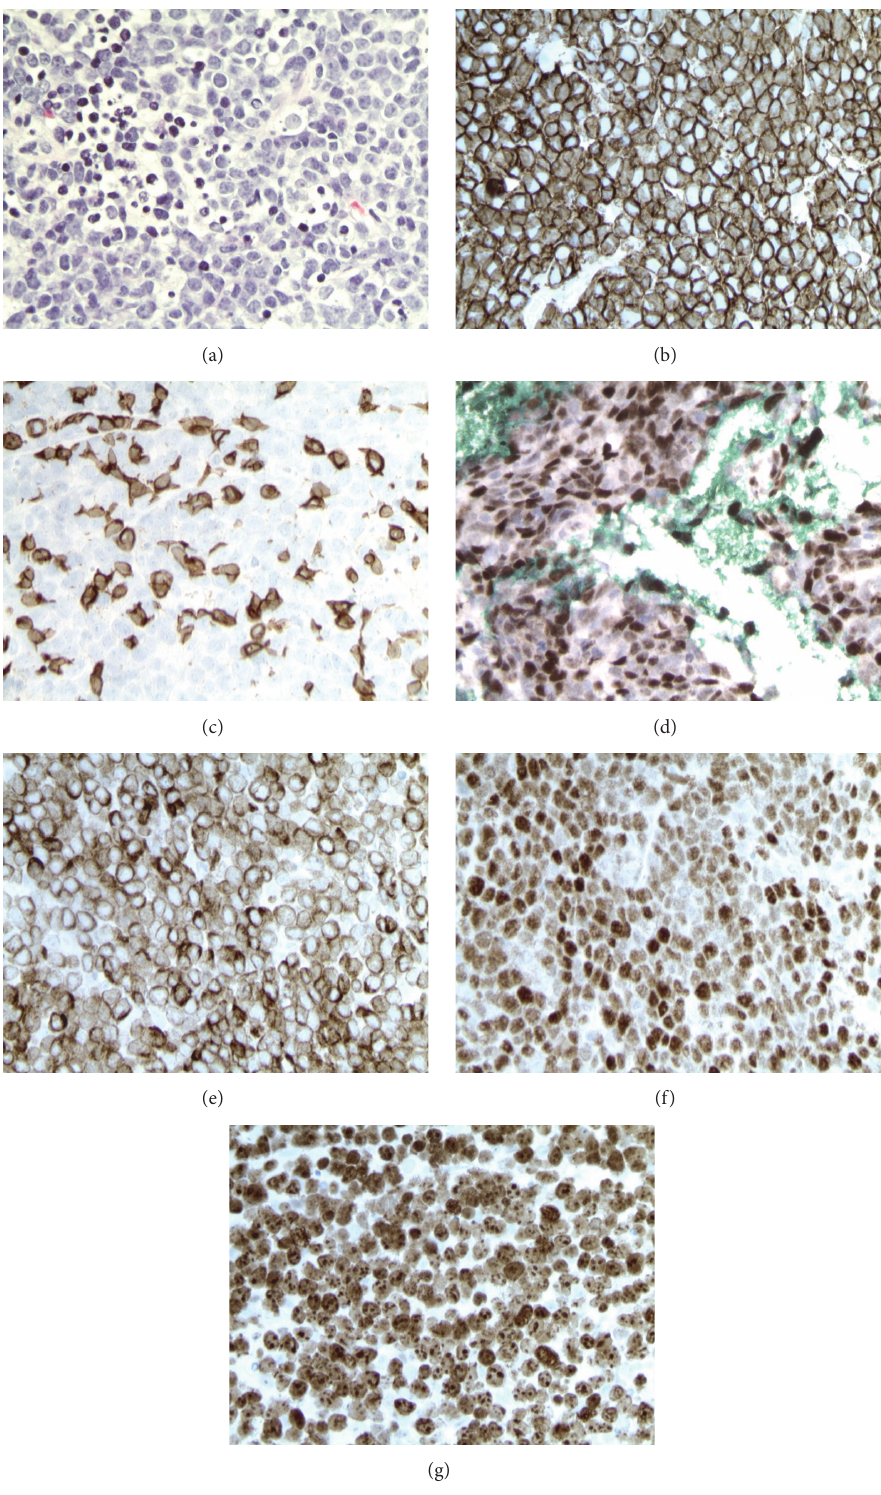
Figure 1: Photomicrographs of the needle core biopsy of the conglomerate periaortic lymph node mass. (a) Neoplastic proliferation of large, atypical lymphocytes (hematoxylin and eosin). Immunohistochemical analysis showed that the neoplastic cells were (b) uniformly positive for CD20 but (c) negative for CD3 (staining observed on small reactive T-cells). (d) MYC was positive in 70–80% of cells. (e) BCL2 and (f) BCL6 were both uniformly positive. (g) Ki-67 was positive in greater than 95% of cells. Images were captured using a Leica DM1000 microscope with digital camera using the manufacturer’s FireCam software (Leica Microsystems, Bannockburn, IL). Original magnification,